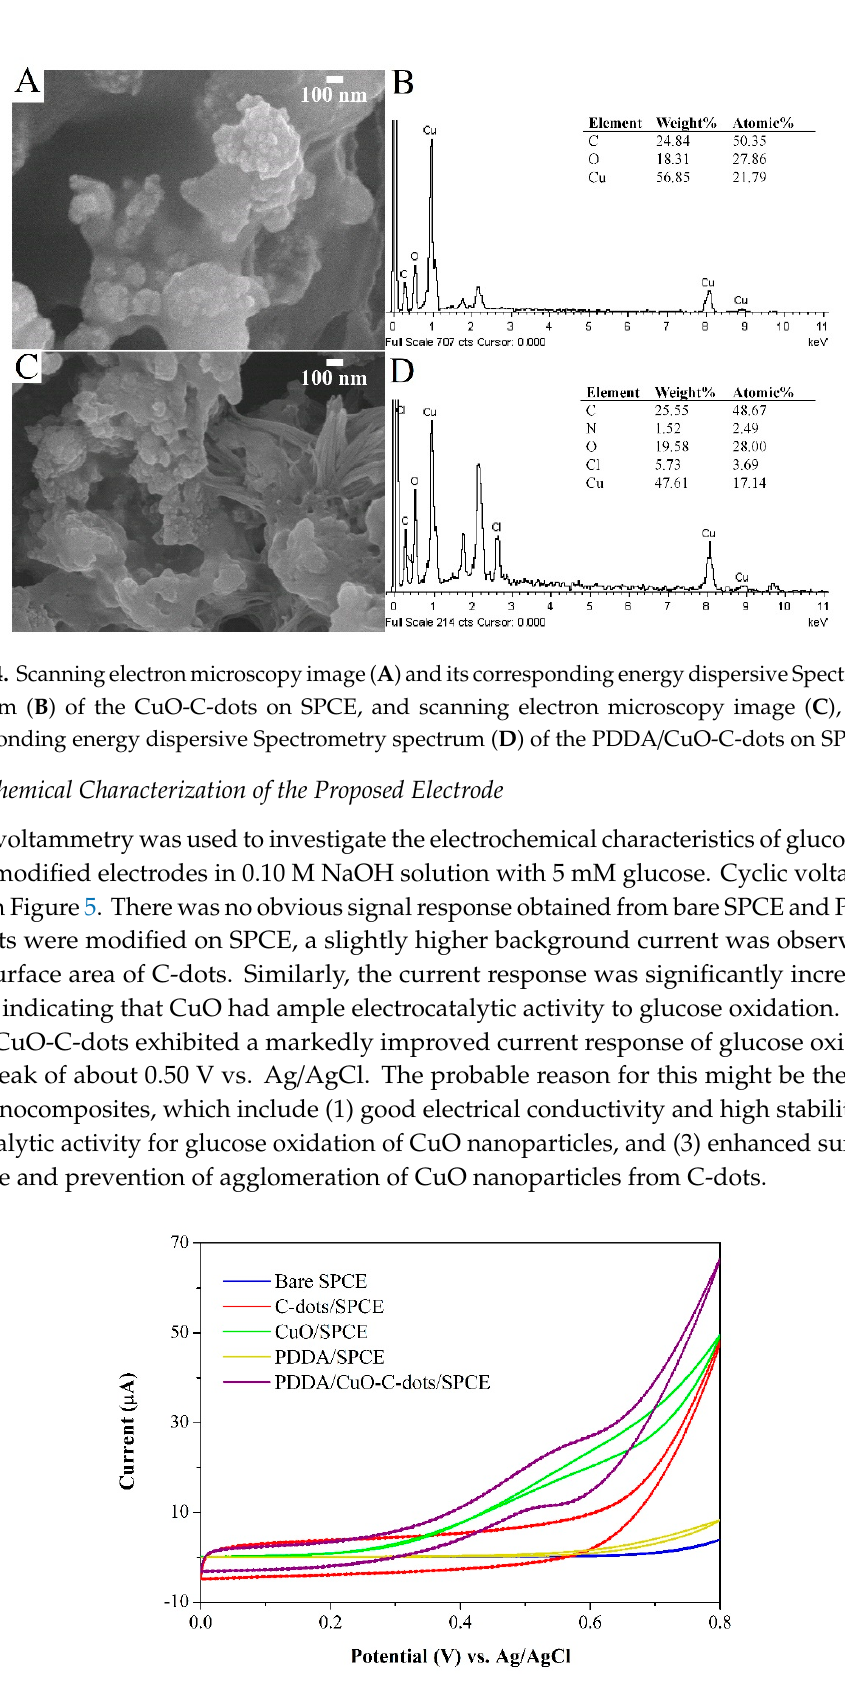
Figure 5. CVs of bare SPCE, C-dots / SPCE, CuO / SPCE, PDDA / SPCE, and PDDA / CuO-C-dots / SPCE for detection of 5 mM glucose in 0.10 M NaOH at a scan rate of 90 mV s − 1 .